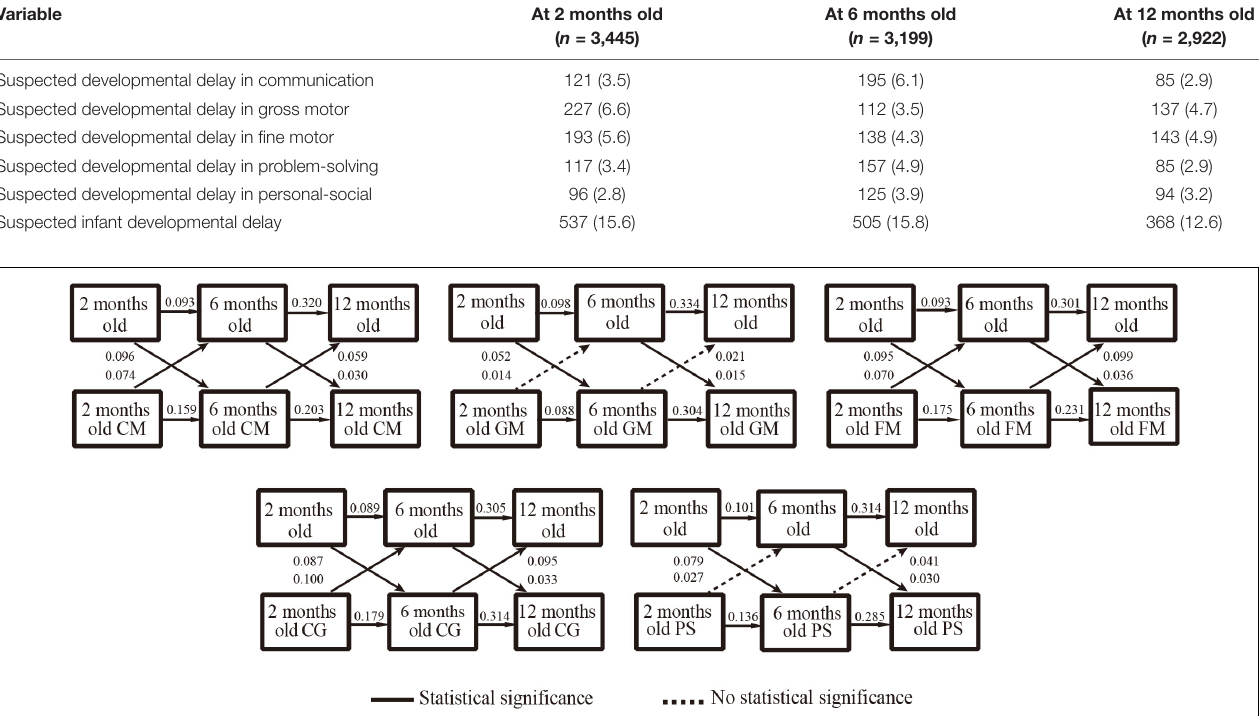
TABLE 1 | Suspected developmental delay in each domain of ASQ-3 and suspected infant developmental delay at 2, 6, and 12 months of age.